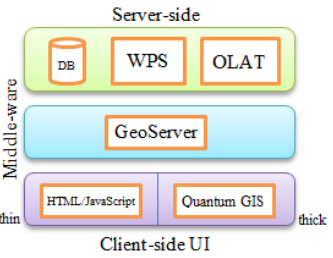
Figure 1. The conceptual framework